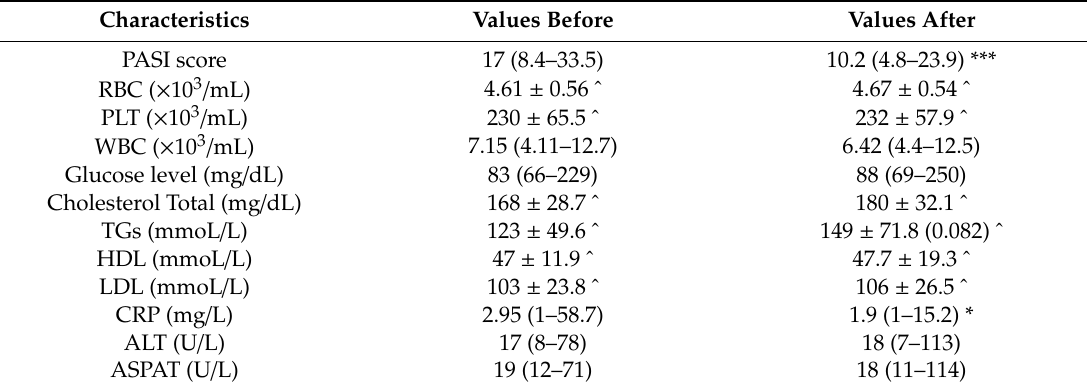
Table 2. Basal characteristic of patients group undergoing